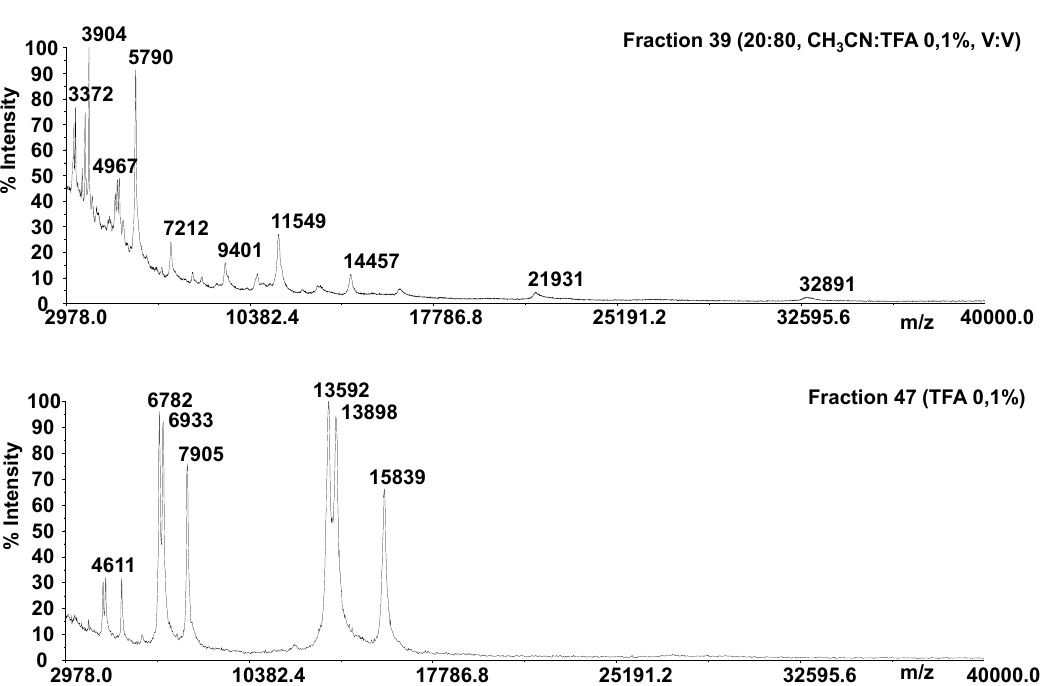
Figure 2. Linear matrix-assisted laser desorption ionization mass spectrometry (MALDI MS) of the chromatographic fractions 39 and 47 .